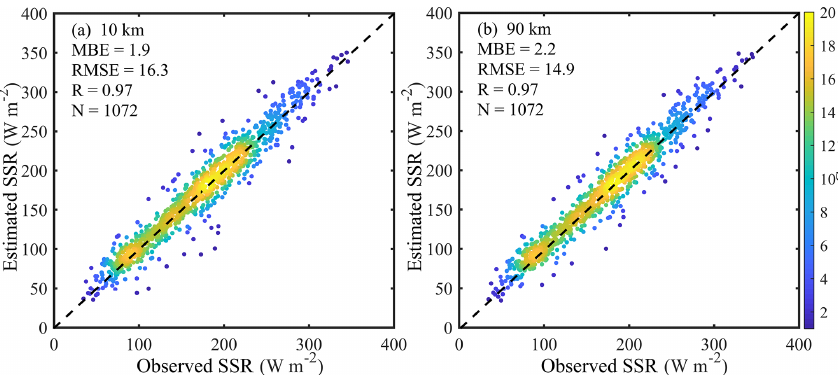
Figure 9. Comparisons of our estimated monthly SSR at spatial resolutions of (a) 10km and (b) 90km with observed monthly SSR at 90 CMA radiation stations.